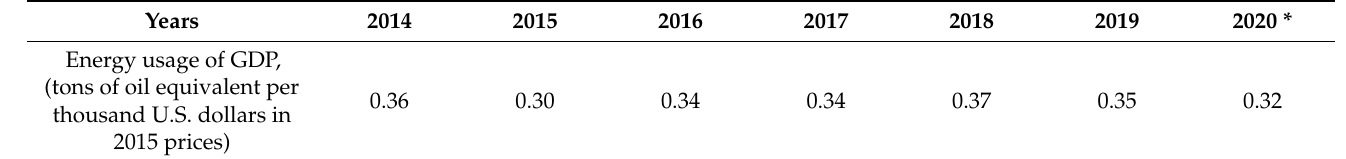
Table 1. Dynamics of the energy usage of Kazakhstan’s GDP for the period